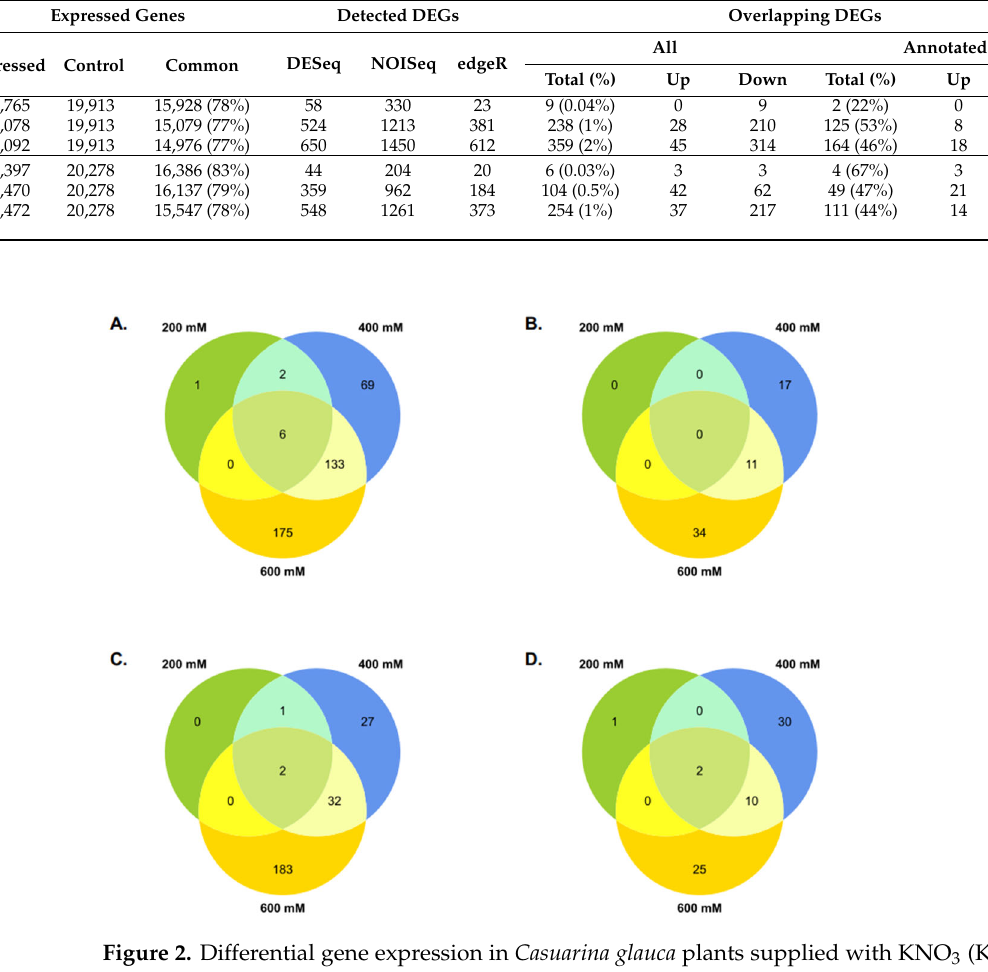
Table 1. Differential gene expression quantification in branchlets of Casuarina glauca nodulated by nitrogen-fixing Frankia casuarinae Thr (NOD + ) or non-nodulated plants supplied with KNO 3 (KNO 3+ ), grown at control (0 mM NaCl) and three salinity conditions (200 mM, 400 mM and 600 mM NaCl). Number of total expressed genes by each plant, at each condition, number of genes expressed by both treatment and control of each comparison (common genes percentage relative to the respective average gene expression between brackets), number of differential expressed genes (DEGs) detected by DESeq, NOISeq and edgeR analyses, number of overlapping DEGs in the three analyses (DEGs percentages relative to the respective average gene expression between brackets) and number of respective annotated DEGs, enumerated by type of regulation. Detected and overlapping DEGs correspond to the number of significant DEGs in each salinity-stress treatment in comparison with the control NaCl (respectively, 200: 200 mM vs. 0 mM, 400: 400 mM vs. 0 mM and 600: 600 mM vs.